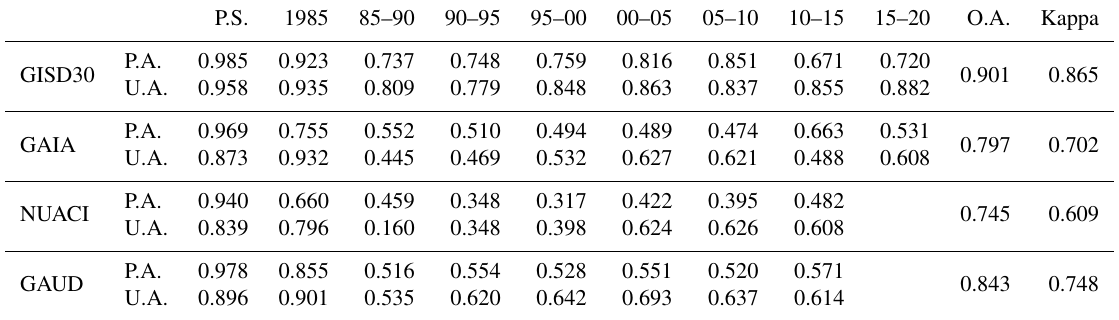
Table 2. The accuracy metrics of four global 30m impervious-surface dynamic products using the same validation